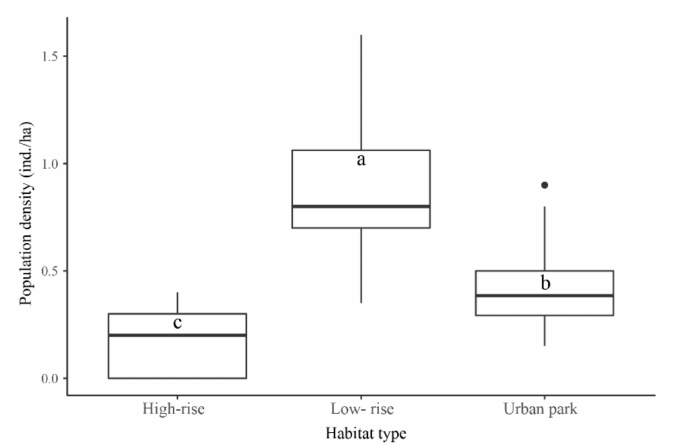
Figure 3. Differences in population density of the oriental magpie-robin between the three habitat types ( n = 24; different letters a–c indicate significant differences between habitat types, p < 0.05).